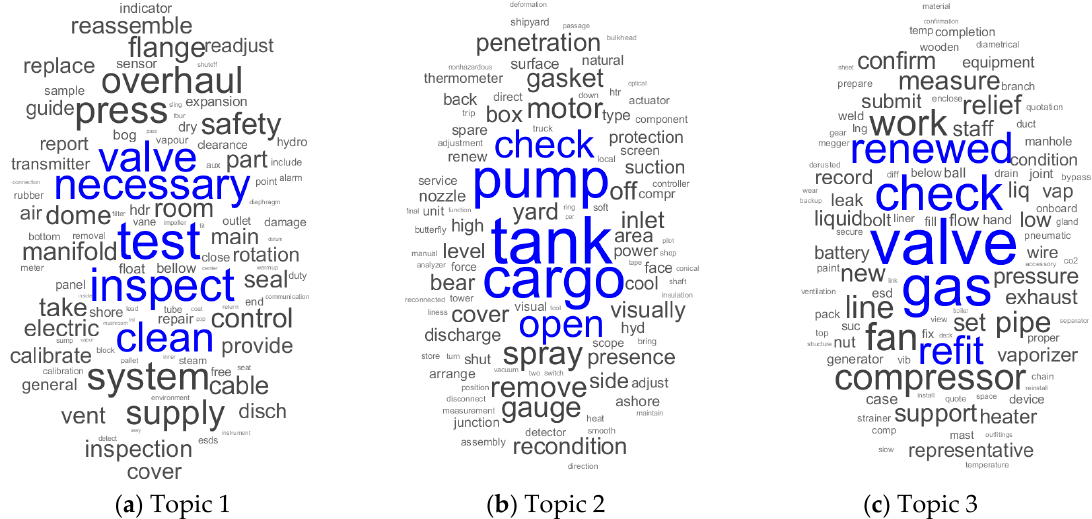
Figure 7. Topic model of LNGCs aged between 10 and 20 years. ( a ) Topic 1: test-inspect-valve; ( b ) Topic 2: tank-cargo-pump; ( c ) Topic 3: valve-gas-renew.